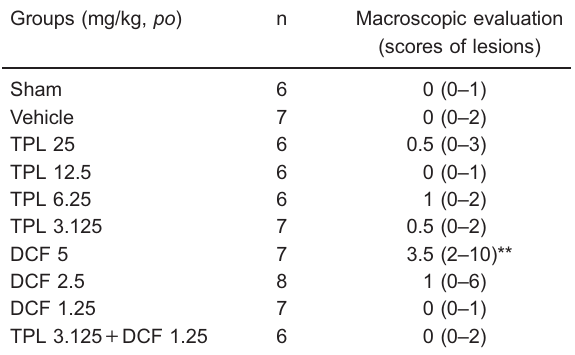
Data are reported as median scores of gastric lesions, with maximum and minimum values in parentheses. ** P o 0.01 vs sham (Kruskal-Wallis test followed by Dunn ’ s